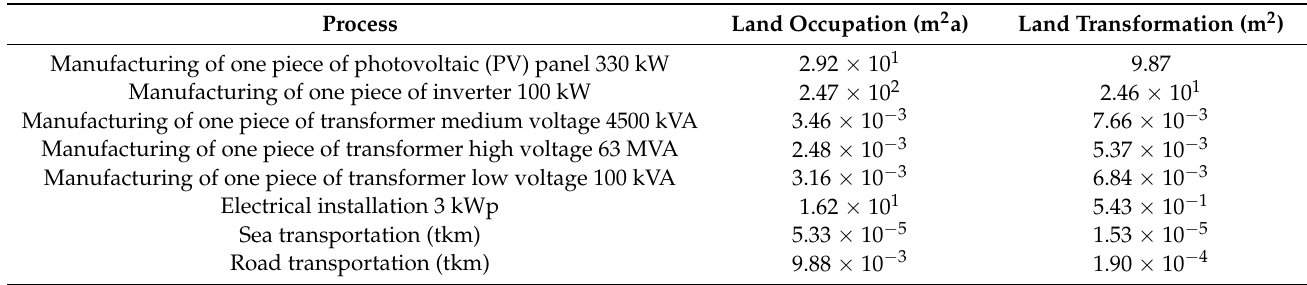
Table 2. Inventory data for background processes. Reproduced from [28], Ecoinvent: 2019.